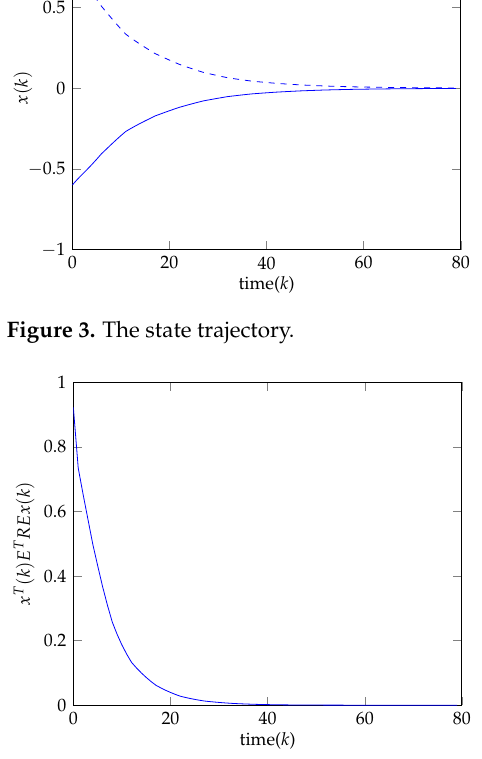
Figure 4. The trajectory of x T ( k ) E T REx ( k ) .